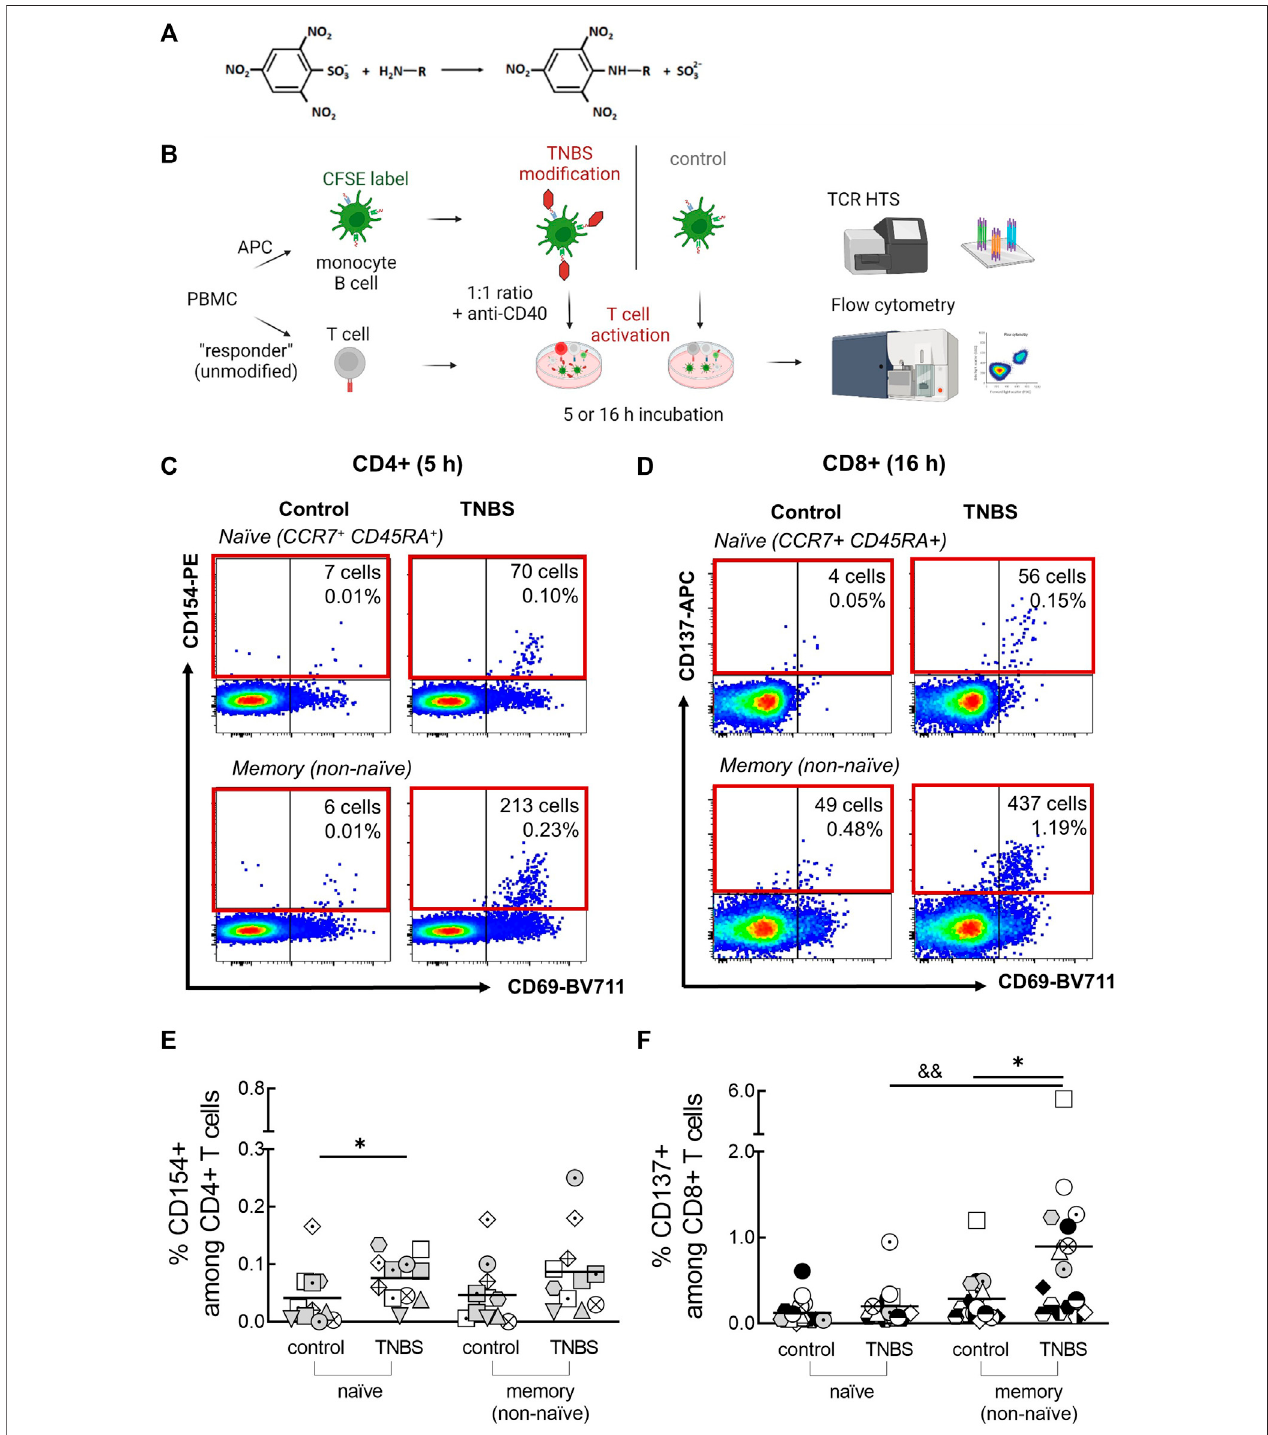
FIGURE1| DetectionofTNBS-speci fi cTcellsbyCD154/CD137upregulation. (A) TNBSreactionscheme.TNBSmainlybindstoprimaryaminogroups. (B) Assay setup.PBMCwerelabeledwithCFSE,modi fi edwithPBSorTNBSandmixedasAPCwithunmodi fi edautologous “ responder ” PBMC.CD4+andCD8+Tcellactivation was detected by fl ow cytometry after 5 and 16 h, respectively, and activated cells were sorted for TCR HTS. Created with BioRender.com. (C,D) Representative dot plots showing numbers and frequencies of CD154+CD4+ [ (C) , MLB20] and CD137+CD8+ [ (D) , MLB31] naive and memory T cells after incubation with PBS- (control) or TNBS-modi fi ed APC. (E,F) Summarized frequencies of TNBS-speci fi c CD4+ (E) , n = 11) and CD8+ T cells [ (F) , n = 17]. Each symbol represents one donor (buffy coats, Supplementary Table S1 ). The gating strategy can be found in Supplementary Figure S4 . Horizontal lines indicate the mean values. Statistical signi fi cances were determined by non-parametric Mann-Whitney t -test (* p < 0.05 vs. control; && p < 0.01 vs. naïve TNBS).